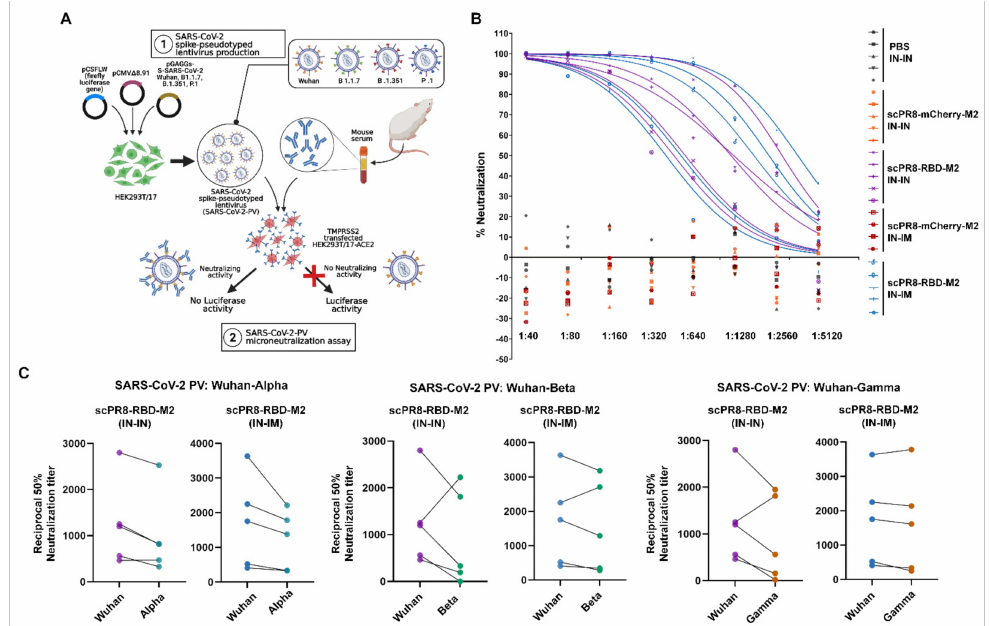
Figure 6. The scPR8-RBD-M2 induces neutralizing antibodies against SARS-CoV-2. ( A ) Schematic presentation of a spike pseudotyped virus (spike-PV) neutralization assay. SARS-CoV-2 spike protein sequences derived from Wuhan-HU-1, Alpha, Beta and Gamma variant were used for the generation spike-PV. ( B ) Percentage of neutralization activity of mice sera against Wuhan-PV. ( C ) Comparison between titers of neutralizing antibodies against spike-PV-Wuhan and spike-PV-variants (Alpha, Beta and Gamma) at 21 days post boost. Y-axis values show reciprocal dilution of the fifty-percent inhibitory concentration (IC 50